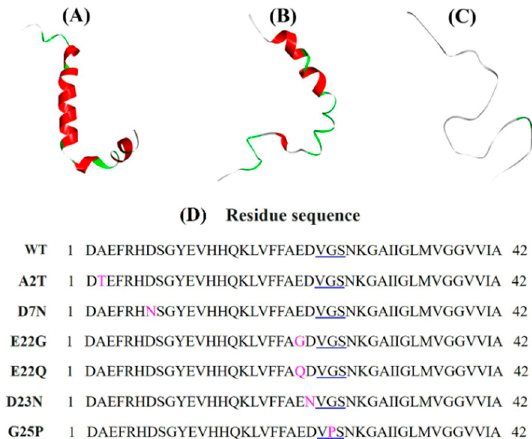
Figure 6. MD simulations were performed on three different structures of A β 1–42 to avoid bias in the initial conformation: ( A ) PDB 1IYT, chain A, model 5 (NMR structure in an apolar microenvironment); ( B ) PDB 1Z0Q, chain A, model 15 (NMR structure in HFIP/aqueous mixture); ( C ) PDB 2NAO, chain B, model 5 (NMR amyloid fibril structure of disease-relevant A β 1–42 ). ( D ) Residue sequences of the